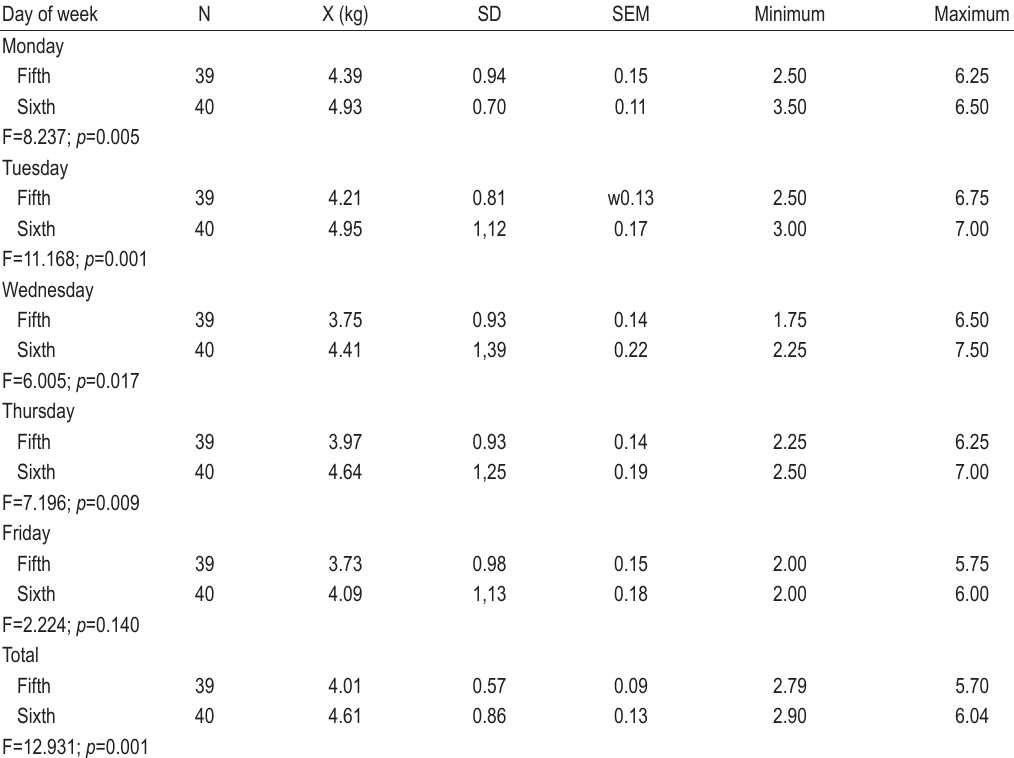
FIGURE 2. Methods of carrying schoolbag among fifth‑ and sixth‑grade students of elementary school. TABLE 3. Mean schoolbag weight (kg) in relation to workdays of the